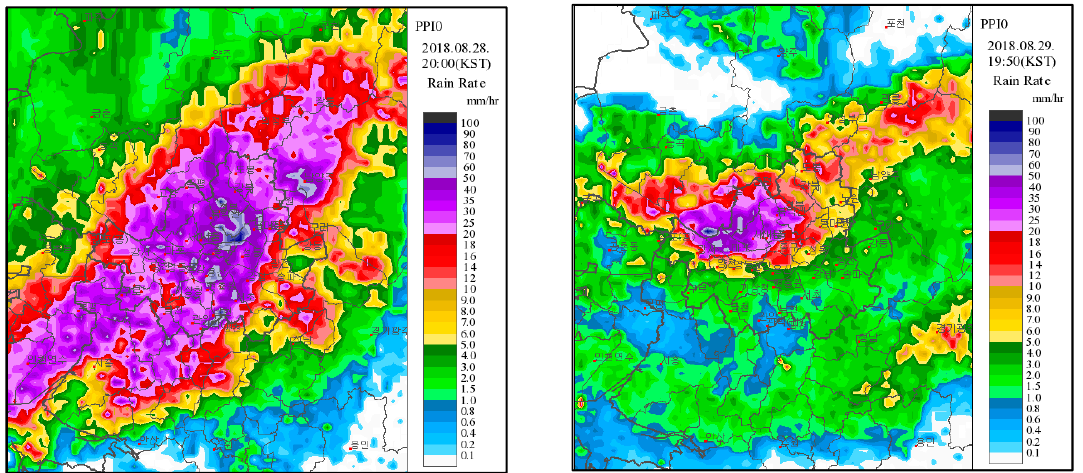
Figure 4. Radar image of the Korea Meteorological Administration (KMA) ( left ) at 20:00 on 28 August 2018 (KST), ( right ) at 19:50 on 29 August, 2018 (KST).